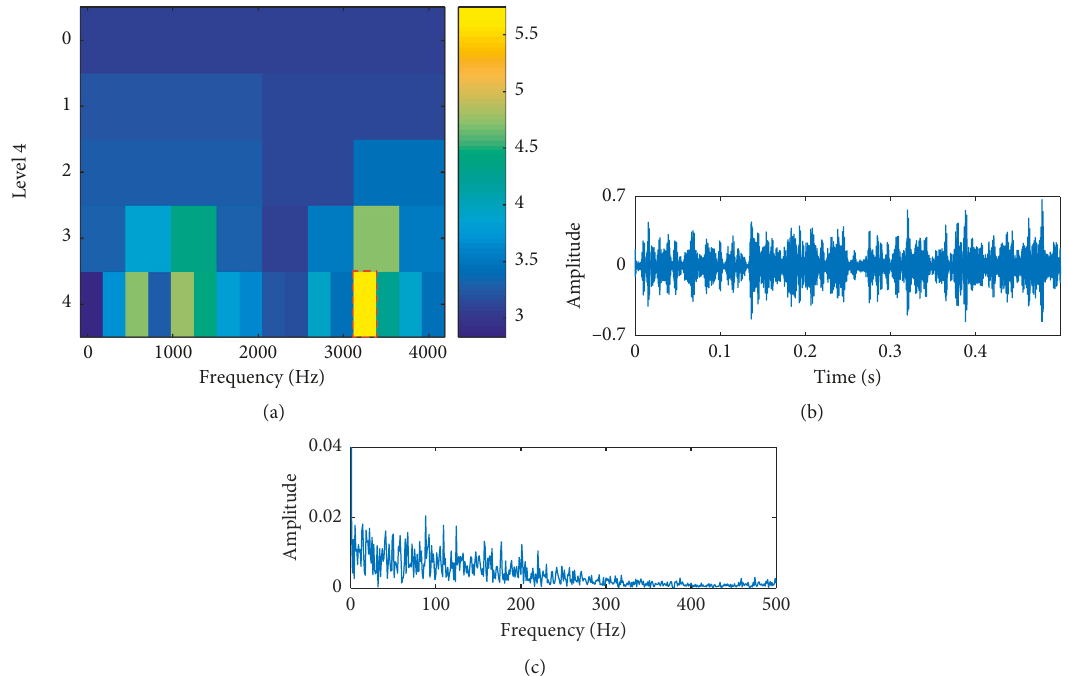
Figure 8: Diagnosis results of the simulation signal by WPT-FSK: (a) kurtogram; (b) TW of the filtered signal with the maximal kurtosis; (c) ES of (b).